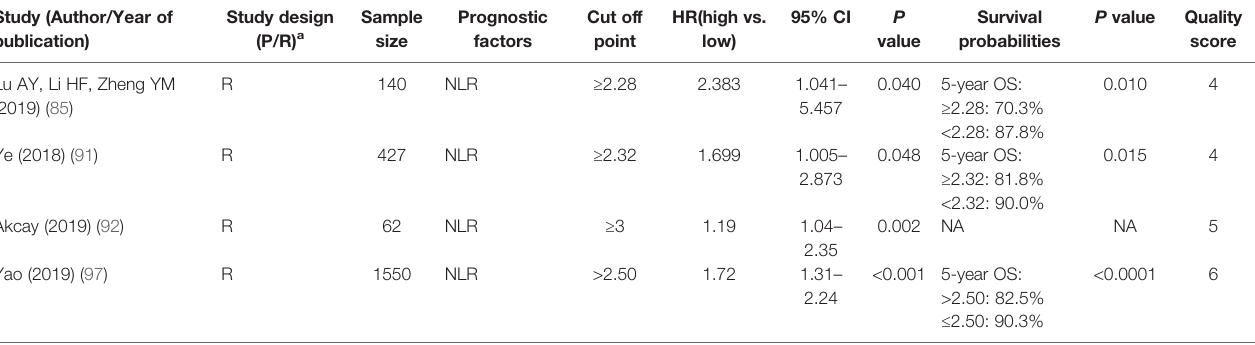
TABLE 5 | Association of overall survival with neutrophil-lymphocyte ratio (NLR)